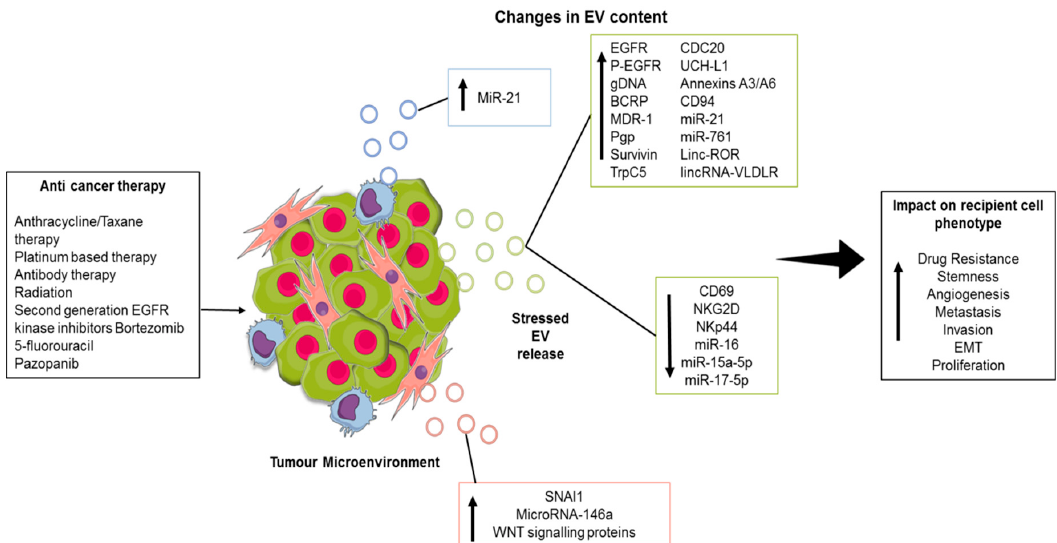
Figure 1. Impact of anticancer therapies on extracellular vesicle EV content and release from the tumour microenvironment. Anti-cancer therapy stress causes EV release from tumour cells and associated stromal cells including cancer-associated fibroblasts (CAFs) (pink) and tumour-associated macrophages (TAMs) (Blue). The resultant EVs have altered content including various bioactives that can have a phenotypic impact in recipient cells. This figure was created using MindtheGraph. Abbreviations: epidermal growth factor receptor (EGFR), phosphorylated-EGFR (P-EGFR), genomic DNA (gDNA), breast cancer resistance protein (BCRP), multi-drug resistance protein 1 (MDR-1), P-glycoprotein (Pgp), short transient receptor potential channel 5 (TrpC5), cell-division cycle protein 20 (CDC20), long intergenic non-protein coding RNA, regulator of reprogramming (Linc-ROR) LincRNA-very